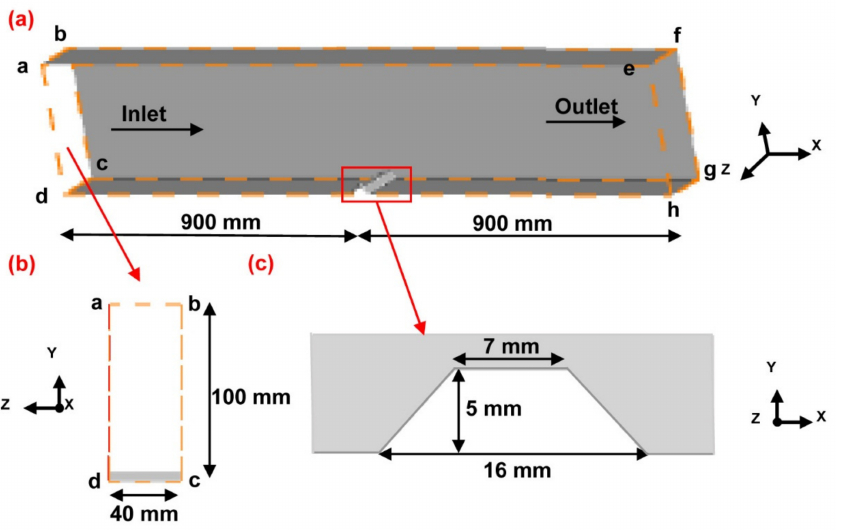
Figure 4. ( a ) CFD geometry model for simulating fluid flow near WRH in the square channel and sectional dimensions of ( b ) square channel and ( c ) trapezoidal